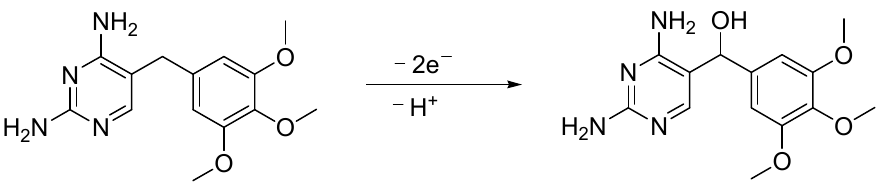
Figure 4. ( A ) Differential pulse voltammograms obtained for various TMP concentrations from 0.9 μ M–100 μ M (1–13); ( B ) Dependence of Ip vs. concentration. A linear range confined to a lower concentration was selected for quantification. With the help of the standard deviation and slope of the graph, limit of detection (LOD) and limit of quantification (LOQ) were computed by applying the below Equations [39]: LOD = 3 s/m (6) LOQ = 10 s/m (7) The calculated LOD and LOQ were 2.06 × 10 − 8 M and 6.89 × 10 − 8 M, respectively. The calibration characteristics of TMP are shown in Table S1. The obtained LOD value was compared with the other reported methods (Table 1), which illustrated that the fabricated electrode was more efficient in determining TMP than the other methods.